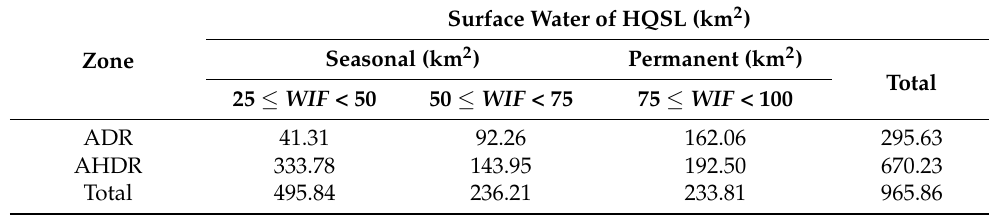
Table 3. Spatial distribution of water in HQSL during 1985–2020.